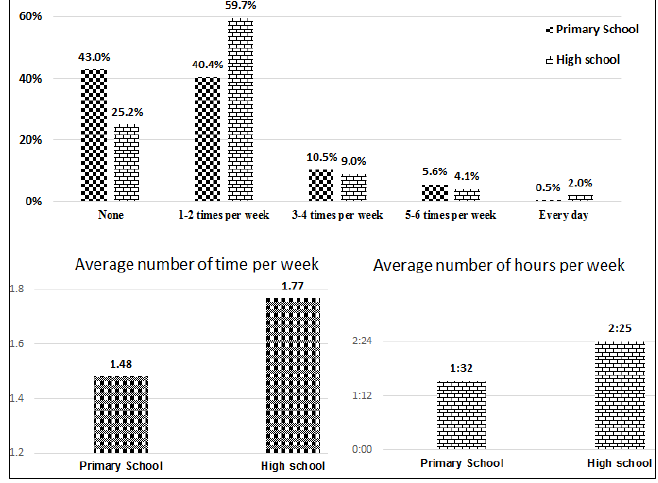
Figure 3. Distribution of c hildren’s physical activity among primary and high school students.